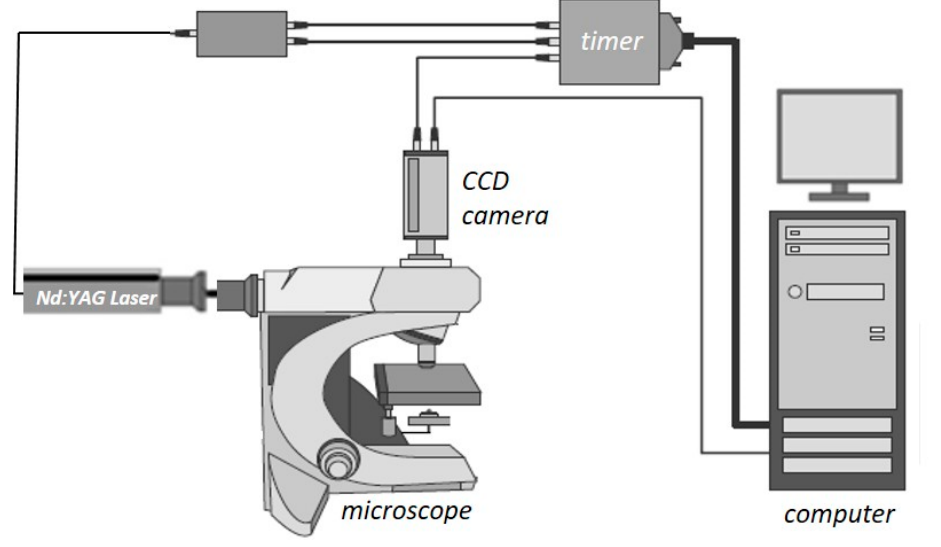
Figure 3. Schematic representation of the μ -LIF experimental setup. Reproduced with permission from [17].